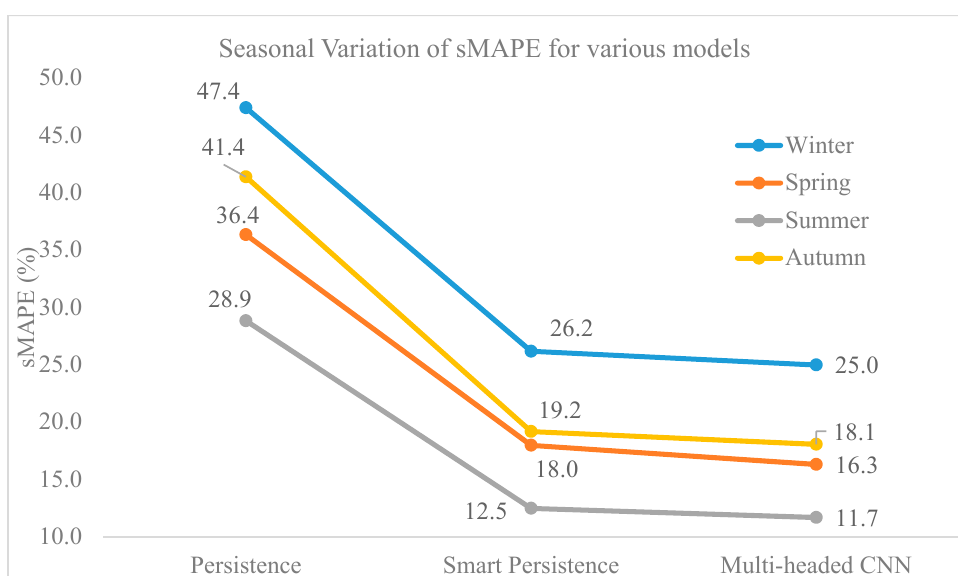
Figure 13. Seasonal variation of sMAPE for forecasting solar irradiance.